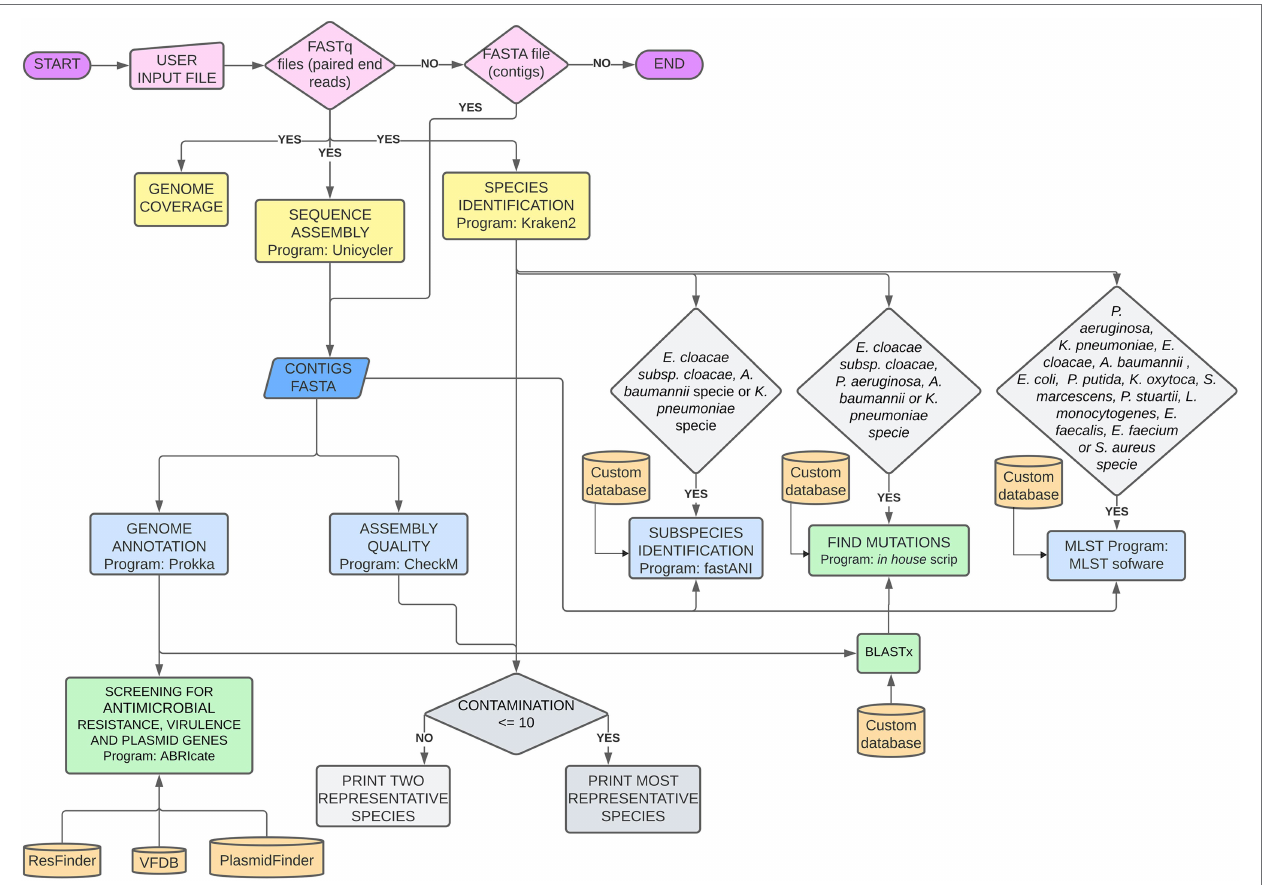
FIGURE 1 | Bioinformatic Pipeline used for genomic sequence analysis. Pink: mandatory files uploaded by the user; Yellow: analyses performed on fastq read files; Blue: analyses performed on fasta contigs files; Green: analyses performed on Prokka outputs; Gray: decisions dependent on two different